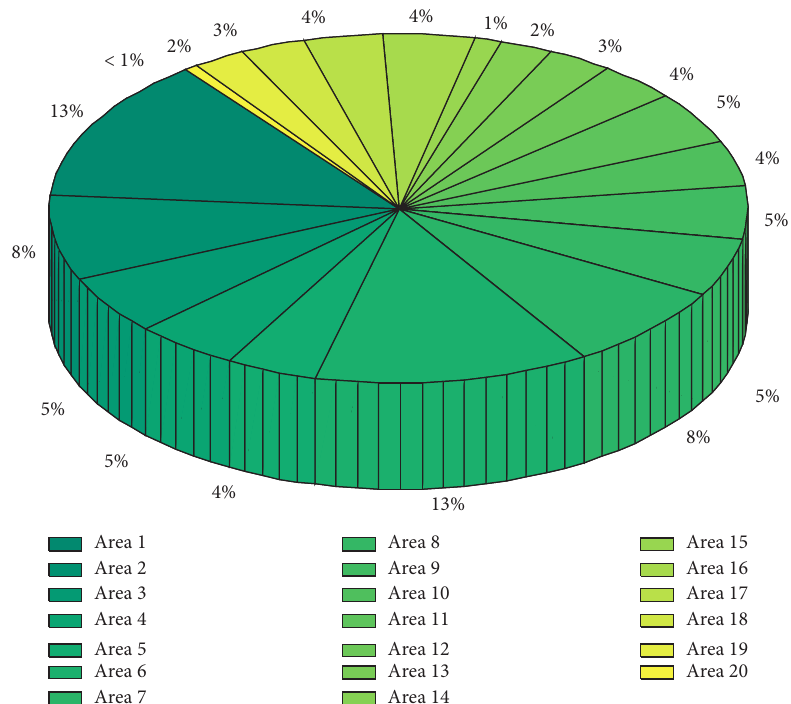
Figure 6: Proportion of the largest market demand capacity Qn in each consumption